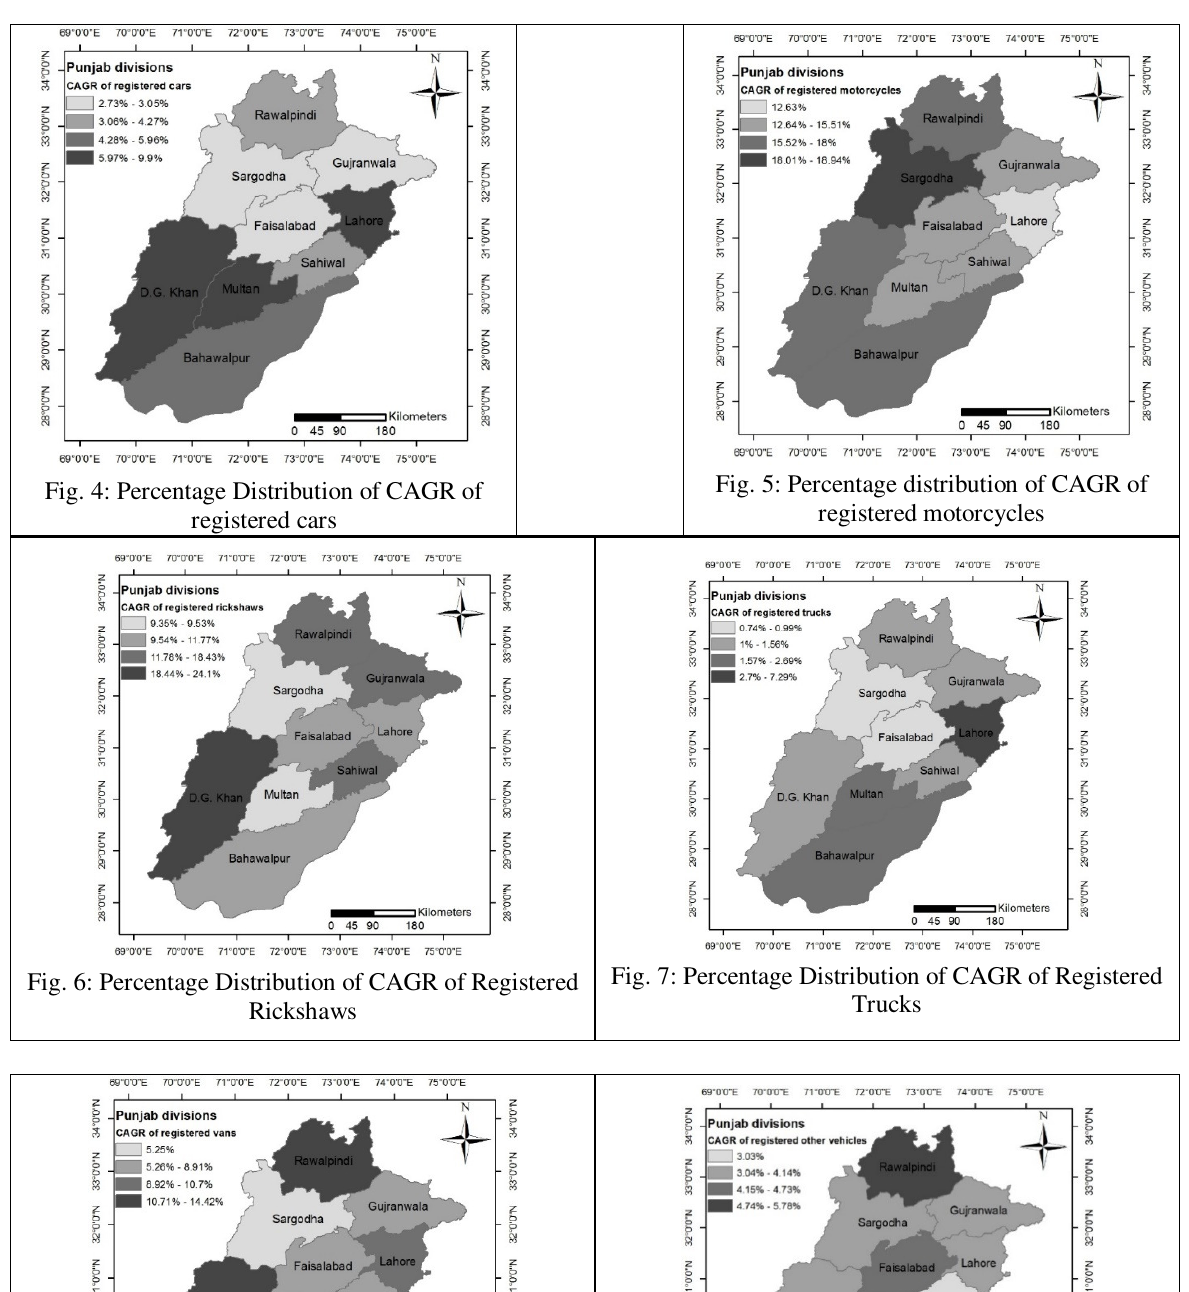
FIGURE 9. PERCENTAGE DISTRIBUTION OF CAGR OF REGISTERED OTHER VEHICLES